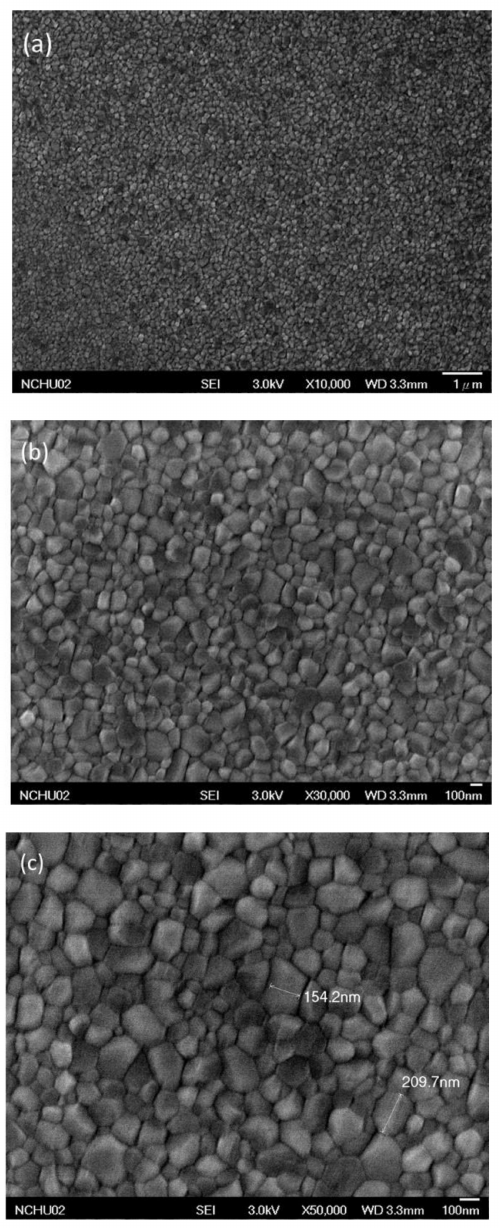
Figure 4. SEM (scanning electron microscopy) images [( a ) × 10,000; ( b ) × 30,000; ( c ) × 50,000] of a MAPbI 3 perovskite film coated on the HTL, recorded after thermal annealing (80 ◦ C, 5